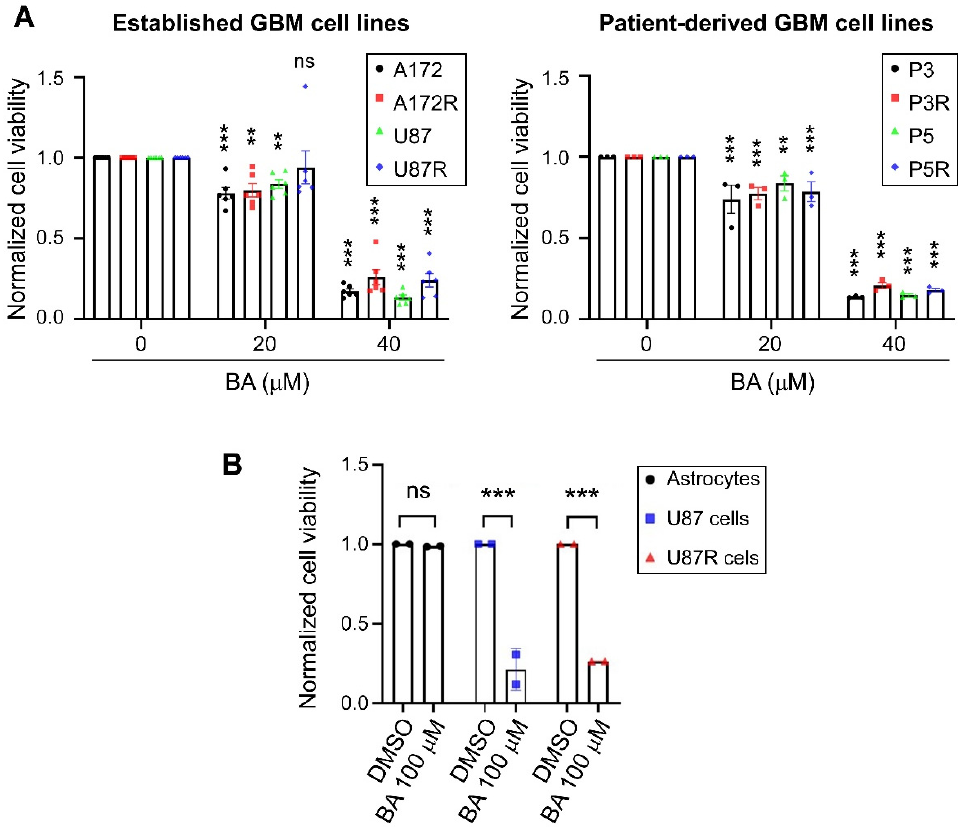
Figure 1. Betulinic acid (BA) suppresses tumor growth and survival in both parental and temozolomide (TMZ)-resistant (R) glioblastoma (GBM) cells, but not normal astrocytes. Cells were treated with 20, ( A ) 40, ( B ) or 100 μ M of BA for 2 days. Dimethyl sulfoxide (DMSO) was used as vehicle control. After treatment, cell viability was determined by 3-(4,5-dimethylthiazol-2-yl)-2,5-diphenyltetrazolium bromide (MTT) assay. Data presented as means ± standard deviations (t-Test: ** p < 0.01 and *** p < 0.001; ns: not significant).